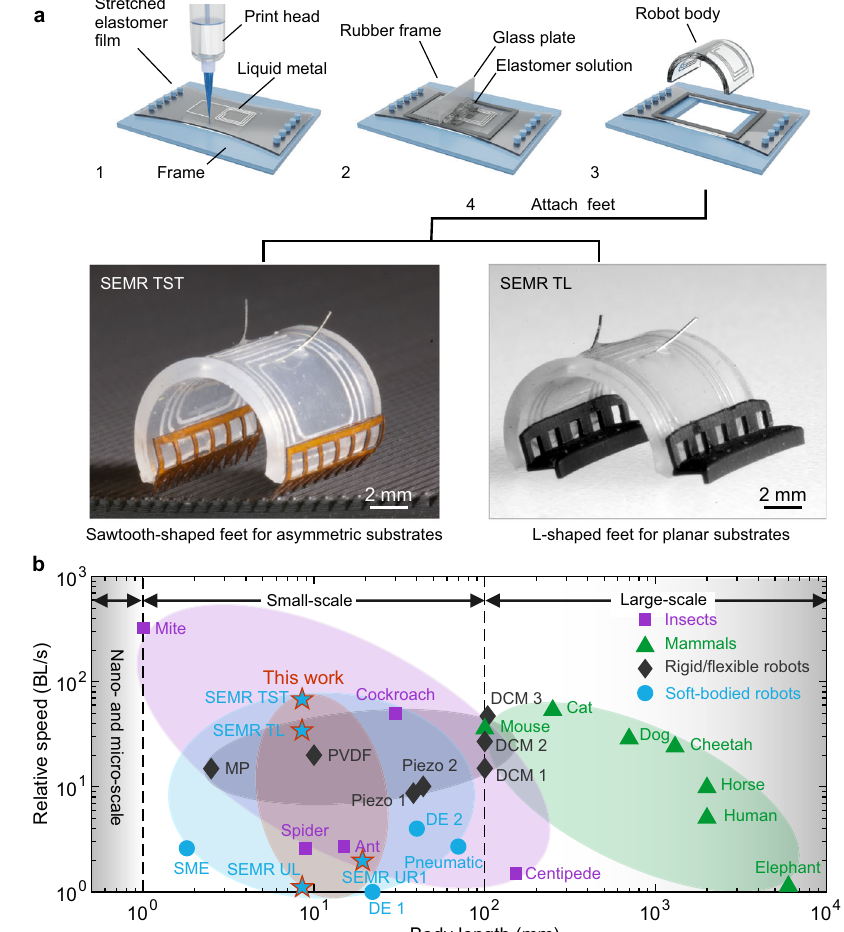
Fig. 1 | Fabrication and performance of SEMRs. a Schematic of the fabrication process. LM coils are printed on a prestretched elastomeric fi lm. Then, the elas- tomer precursor solution is applied on top of the LM coils using bar coating, resulting in a bilayer structure from which the robot body is cut out. Lastly, sawtooth-shaped or L-shaped feet are attached. For actuation, the robots are connected to the external power with electrodes. b Maximum running speeds of representative mammals, arthropods, soft robots, and robots versus body length.